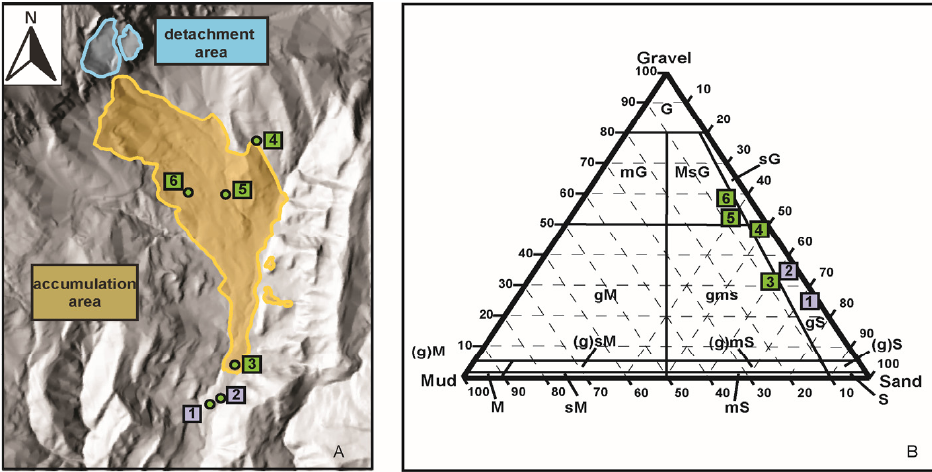
Figure 11. ( A ) location of sampling sites within (3–6) and outside (1–2) the landslide’s accumulation area; ( B ) particle ‐ size texture of the matrix according to Folk’s (1980) classification. area; ( B ) particle-size texture of the matrix according to Folk’s (1980)